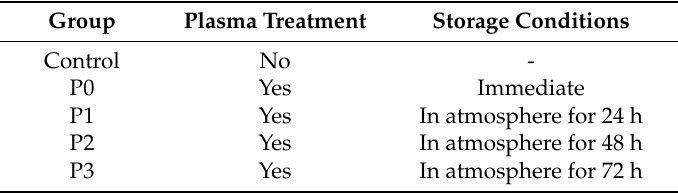
Table 1. Plasma treatment and storage conditions in each group.